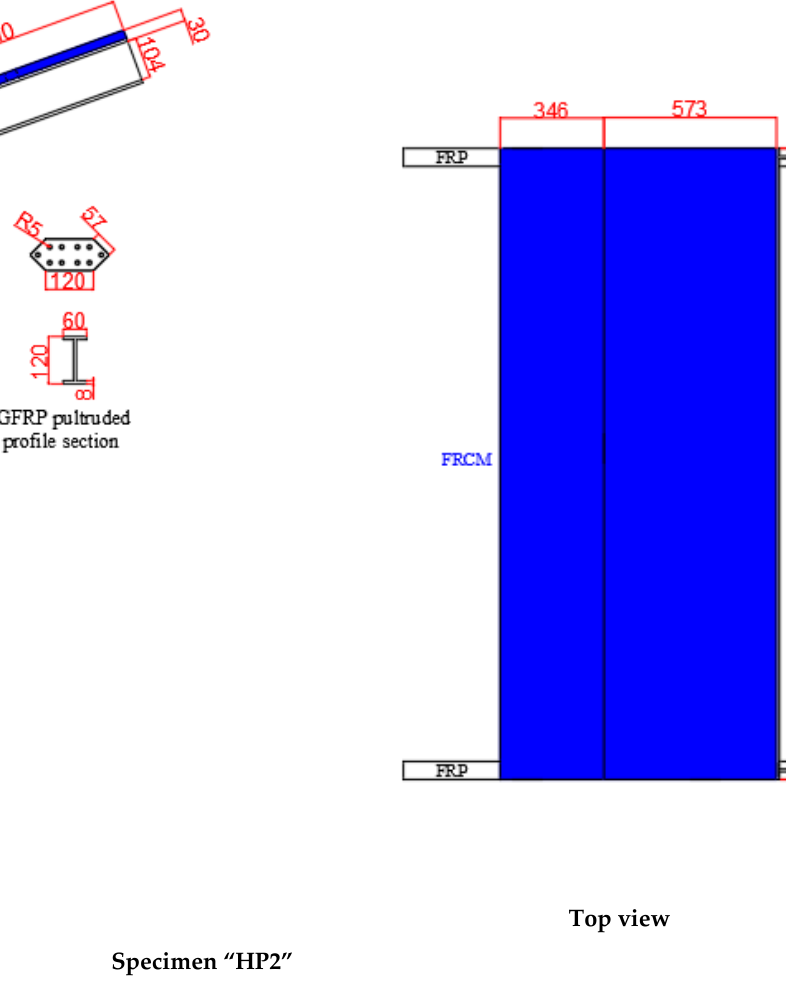
Figure 1. The geometry of the specimens (dimensions in mm). Table 1. The mechanical properties of the GFRP profile